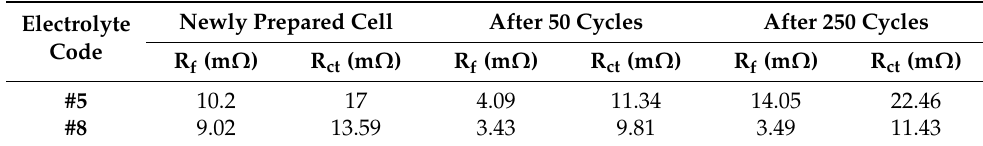
Figure 11. Representative EIS Nyquist plots measured and the fitting curves before and after cycling in different electrolyte models: ( a ) #5 EL (without additive DDDT); ( b ) #8 EL (containing 2 wt.% additive DDDT); ( c ) fitting curves of #5 and #8 EL; ( d ) equivalent circuit model. Table 5. Fitted data of the EIS Nyquist plots.